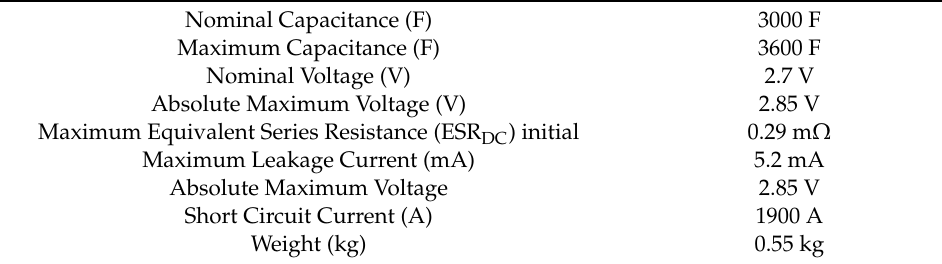
Table 1. Characteristics of the model BCAP300